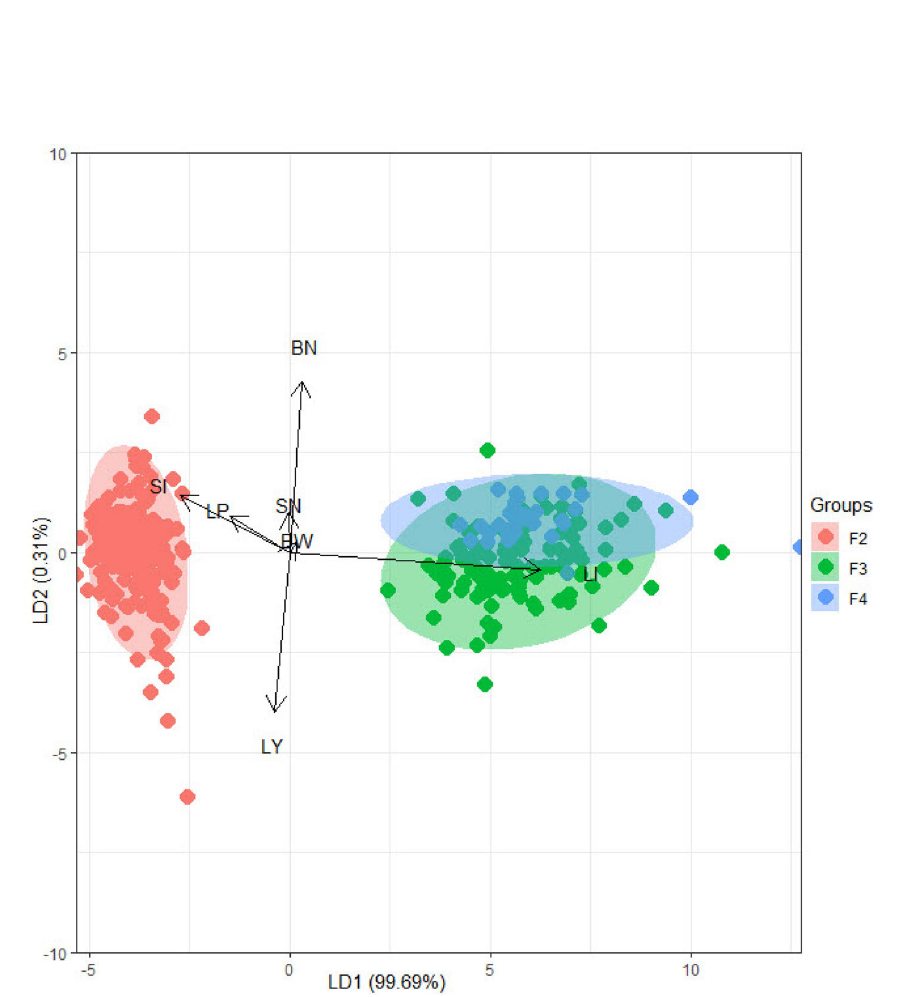
Figure 3. Biplot based on LD1 and